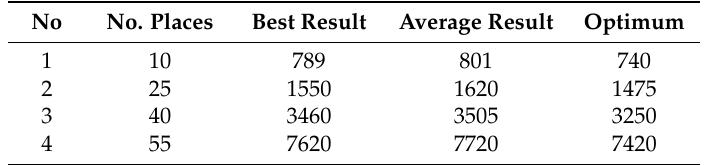
Table 5. Test results for each test instance.